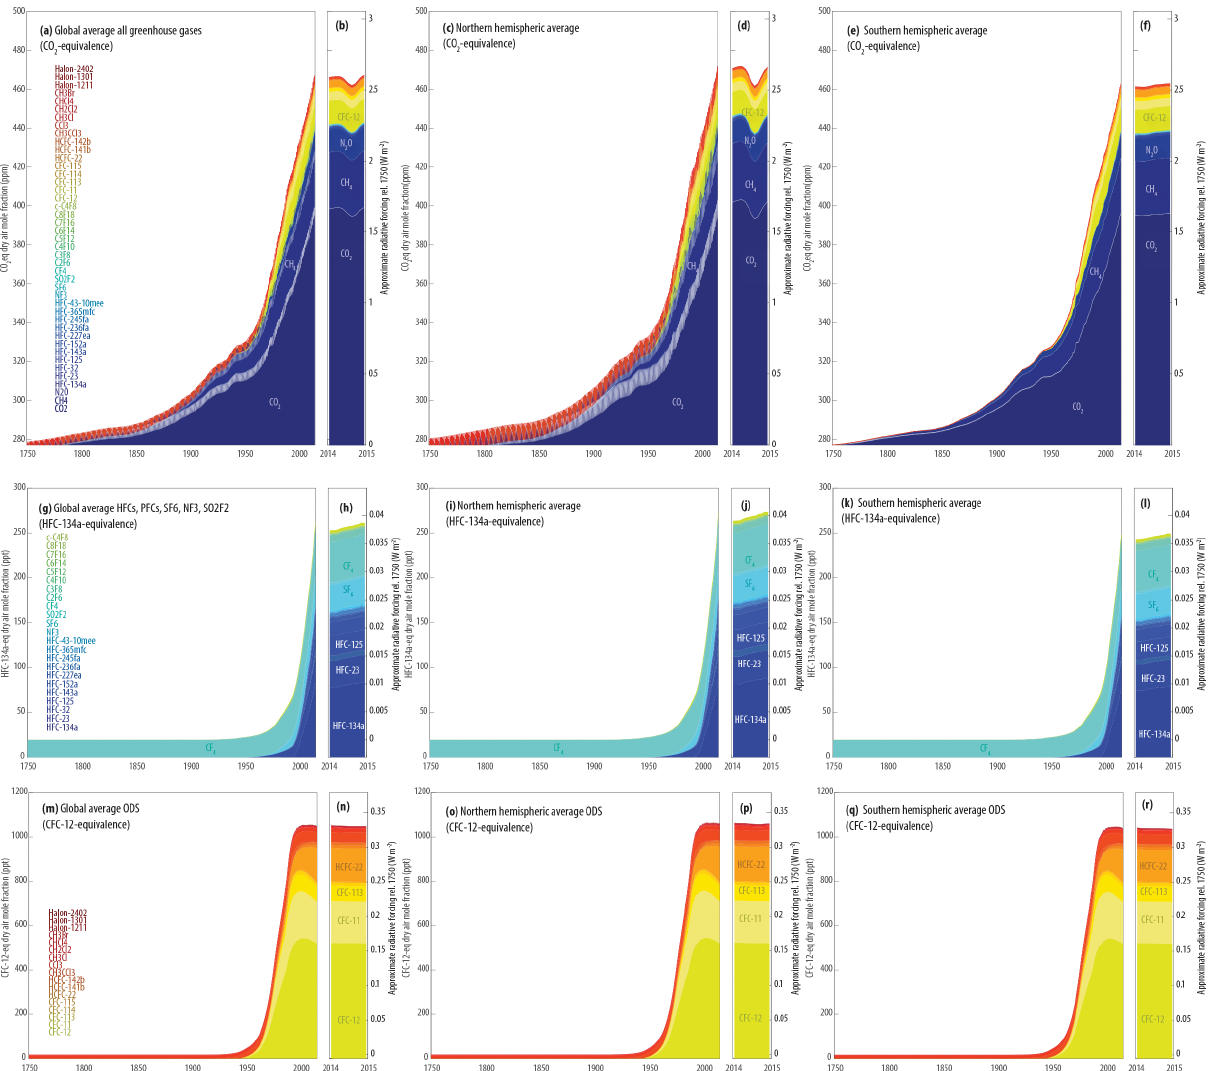
Figure 8. Historical GHG concentrations from 1750 to 2014 as global-mean (right panels), northern hemispheric (middle panels) and south- ern hemispheric averages (right panels). The top row comprises all GHGs, the middle row comprises HFCs, PFCs, SF 6 , NF 3 and SO 2 F 2 . The lower row comprises all ozone-depleting substances, expressed as equivalent CFC-12eq. concentrations. In the narrow boxes, the last data year from 15 January 2014 to 15 December 2015 is shown, indicating the intra-annual trend (top row), increasing gradient (middle row) or relatively flat concentration levels (lower